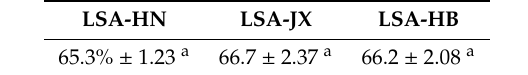
Table 2. Content of alkaloids extracted from Lotus plumules